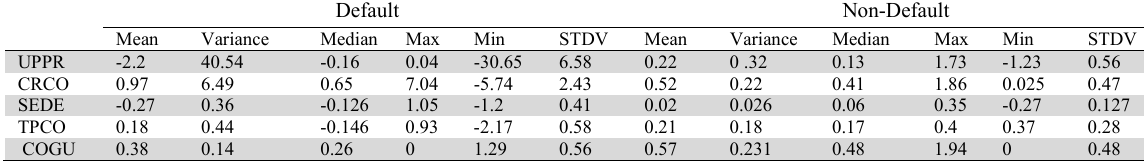
Summary Statistics for Default and Non-Default